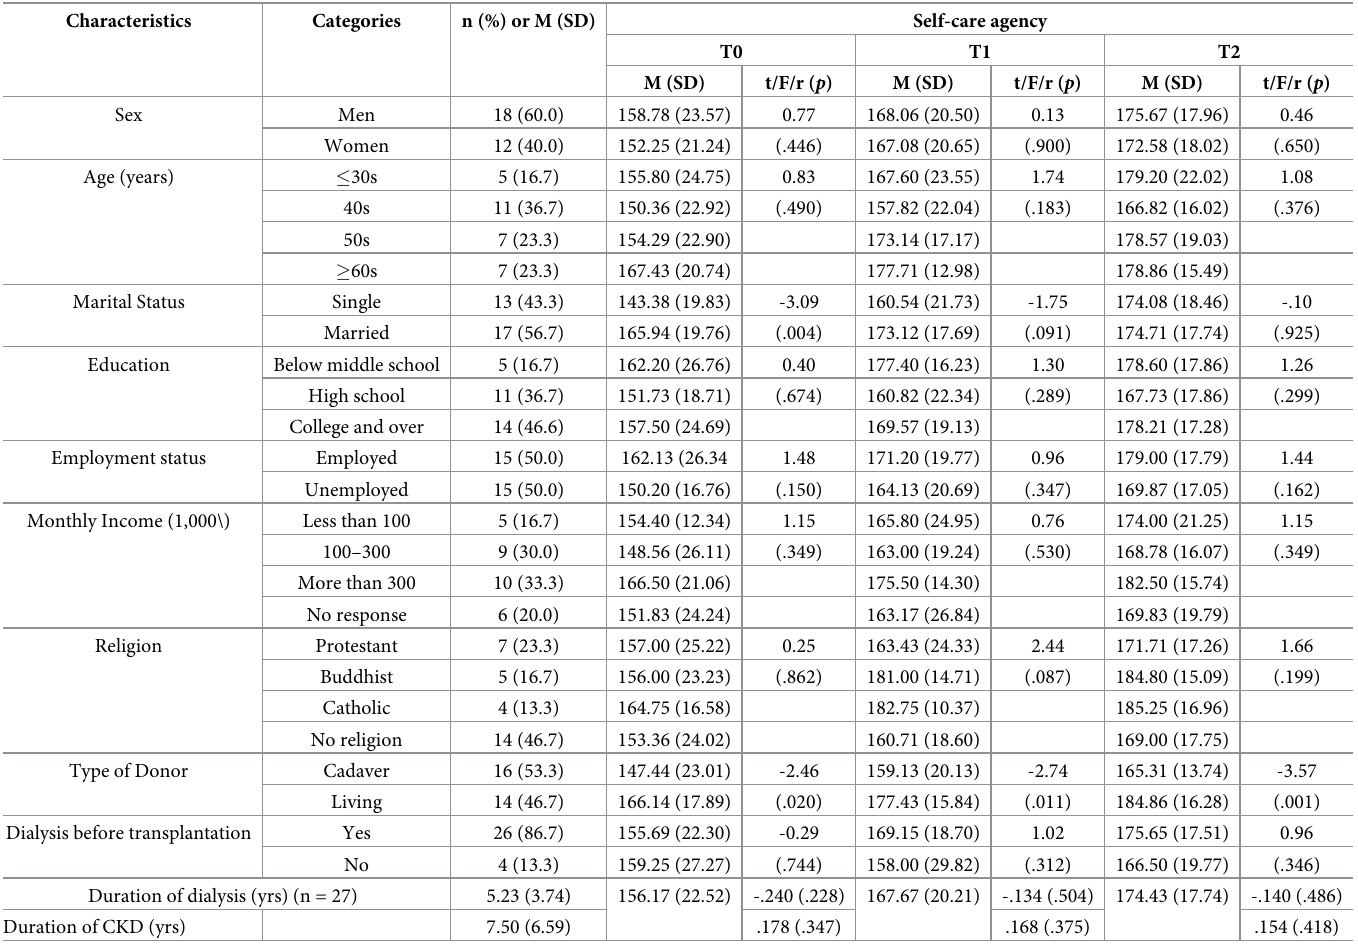
Table 2. Differences in self-care agency by general and transplant-related characteristics (N = 30).